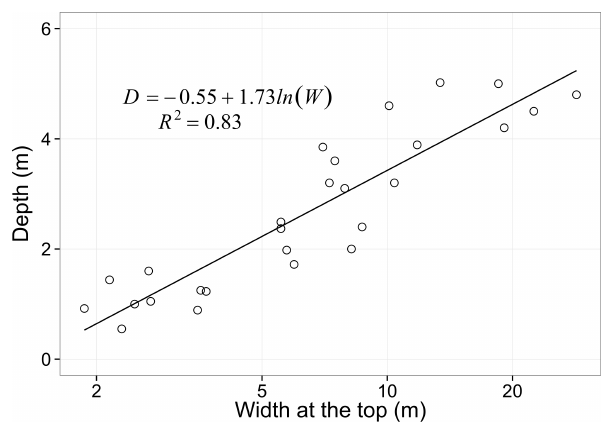
Figure 14. Gully network volume dynamics in the period 1956– 2013 and the uncertainty interval (grey).